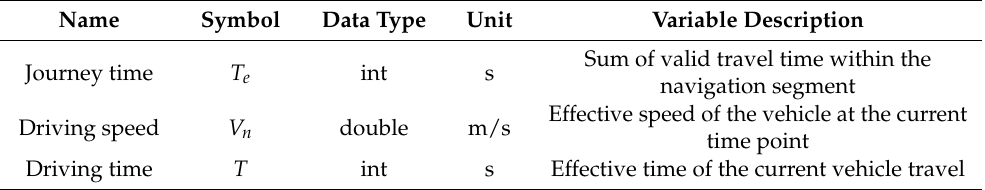
Table 1. Intermediate variables of travel time acquisition